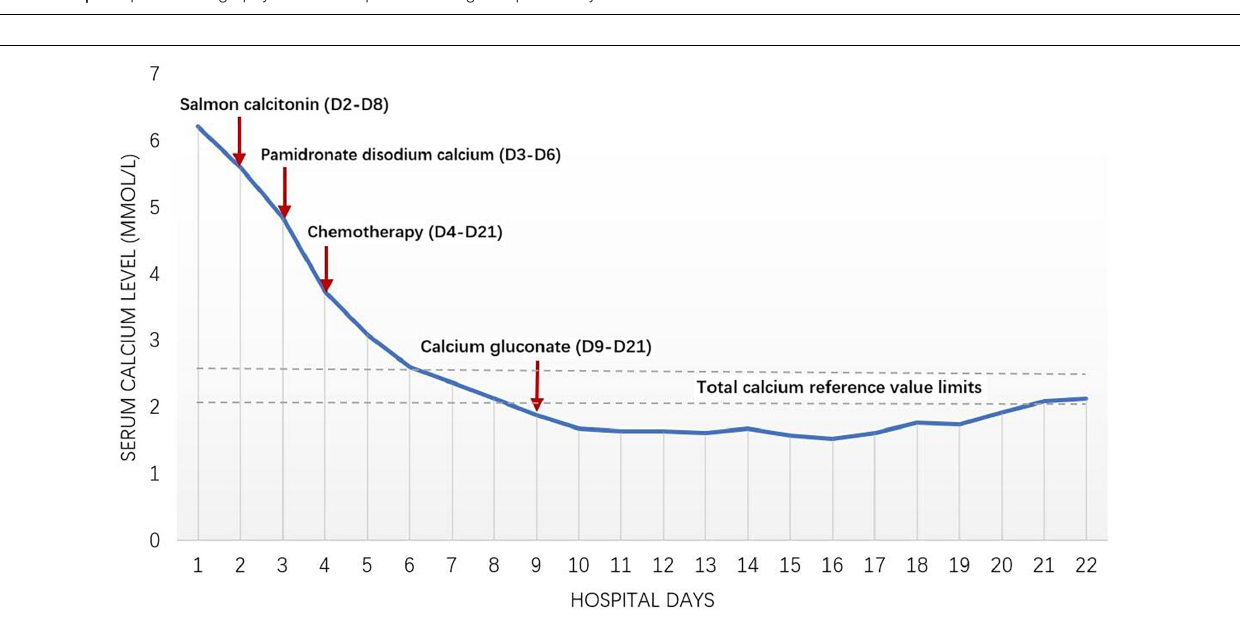
FIGURE 1 | Computed tomography of skull and pelvis showing multiple osteolytic lesions.